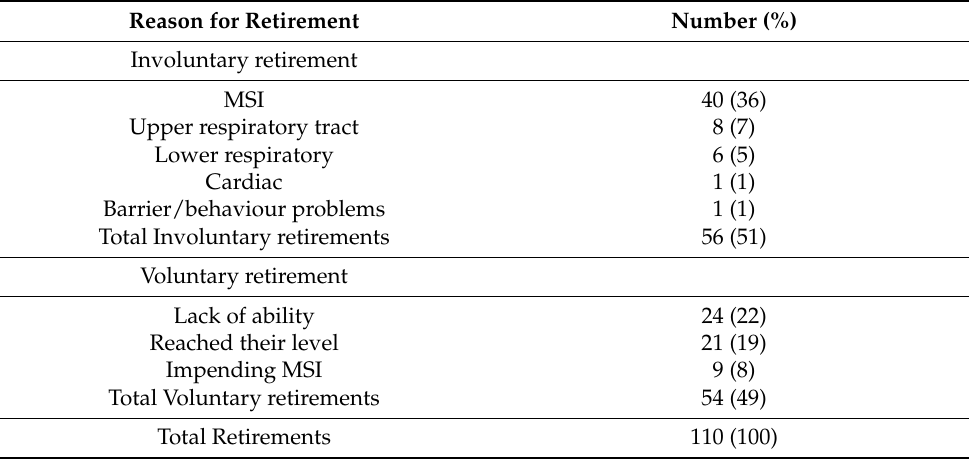
Table 2. The reasons for retirement in 110 Thoroughbred racehorses in South East